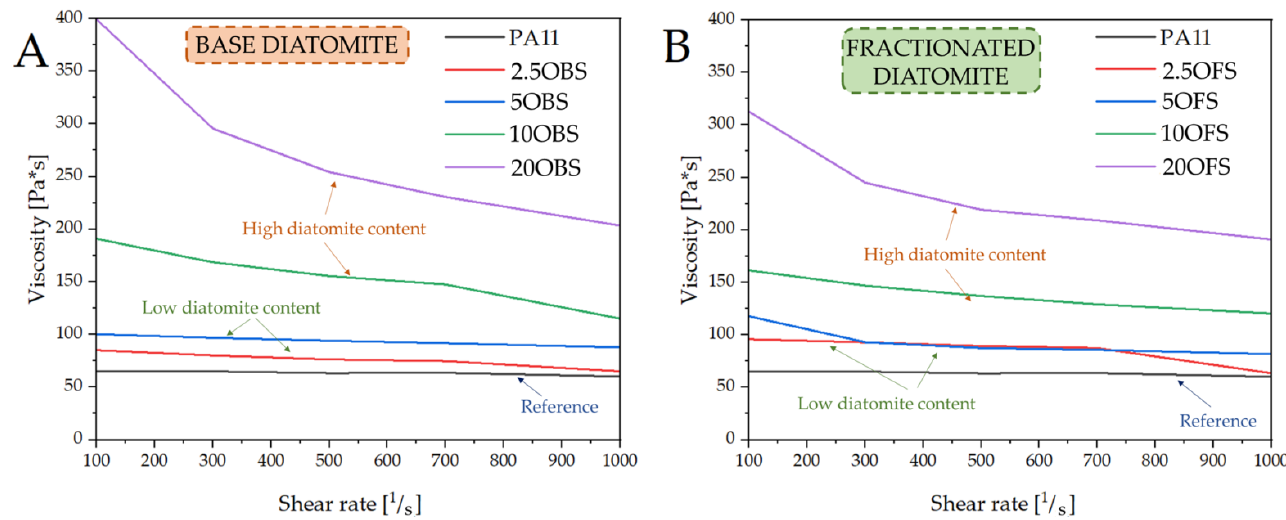
Figure 11. Viscosity of PA11/DE composites after injection moulding: ( A )—PA11 and 2.5–20% OBS, ( B )—PA11 and 2.5–20% OFS.